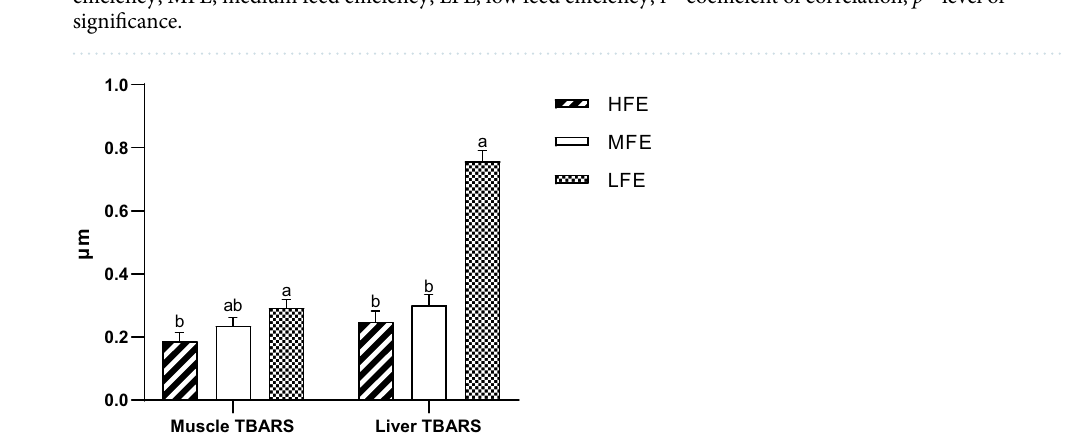
Muscle TBARS Figure 4. Effect of feed efficiency on the lipid peroxidation estimated of muscle and liver tissues obtained from individually housed ISA Brown hens aged 45 weeks old (n = 30, 10 per FE group). TBARS, thiobarbituric acid reactive substances; HFE, high feed efficiency; MFE, medium feed efficiency; LFE, low feed efficiency; abc Means within rows not sharing a common suffix are significantly different at the 5% level of